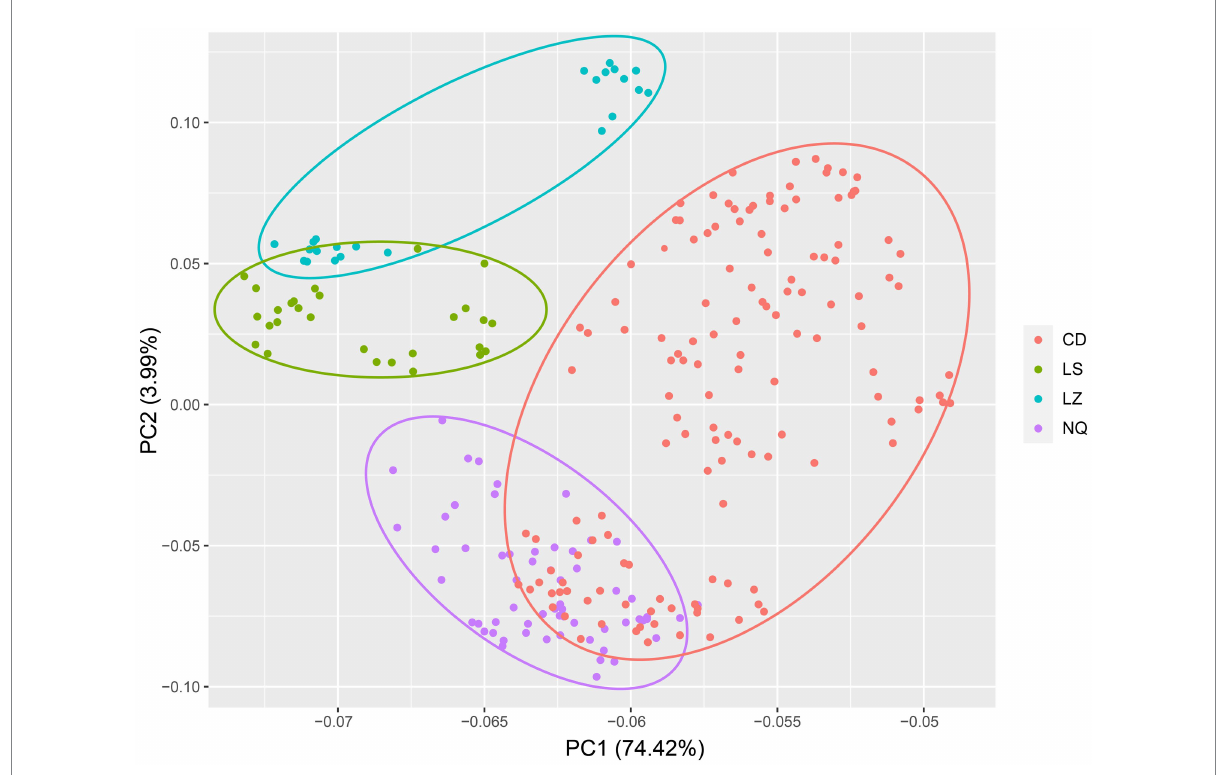
FIGURE 3 Principal coordinate analysis (PCoA) of the E. breviaristatus populations.